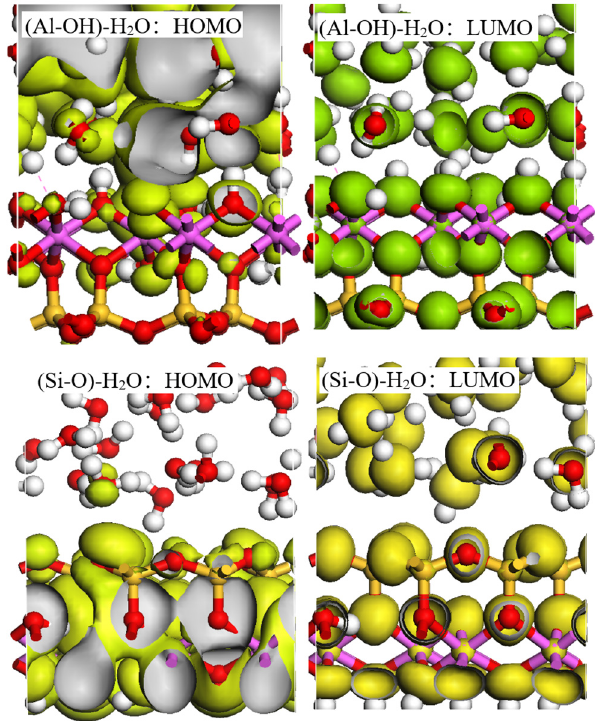
Figure 2. Front orbital of (Al-OH)-H 2 O and (Si-O)-H 2 O interface.